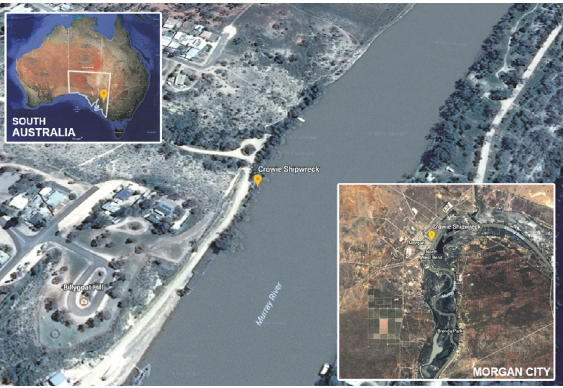
Figure 5: Map of the survey area in Morgan (South Australia).